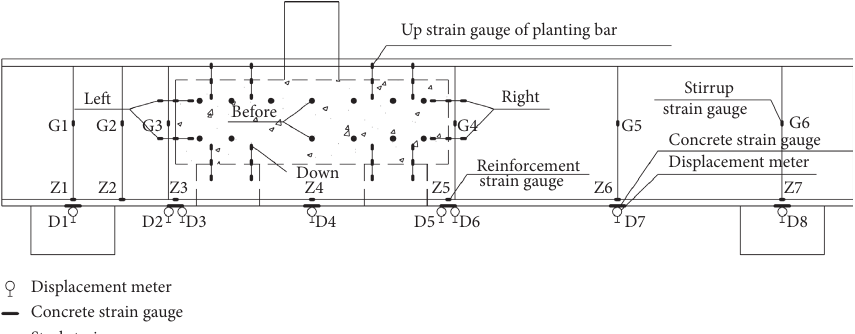
Figure 8: Measuring points.